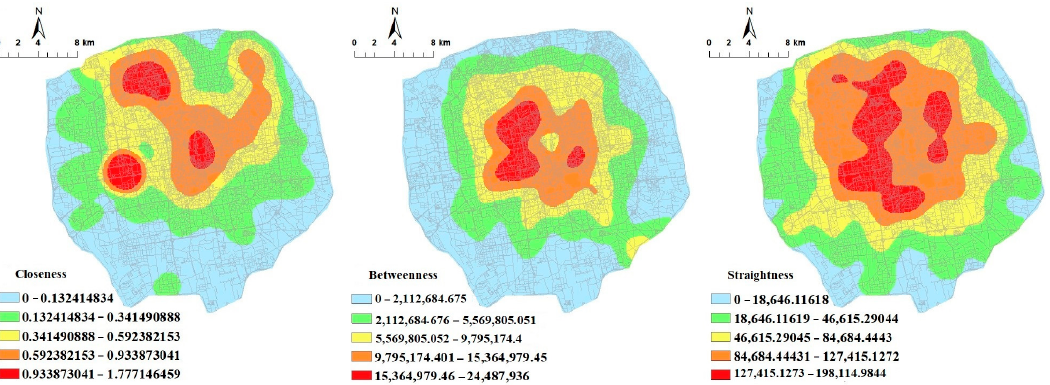
Figure 4. Distribution of kernel density estimation values for the centrality indices of the road network.